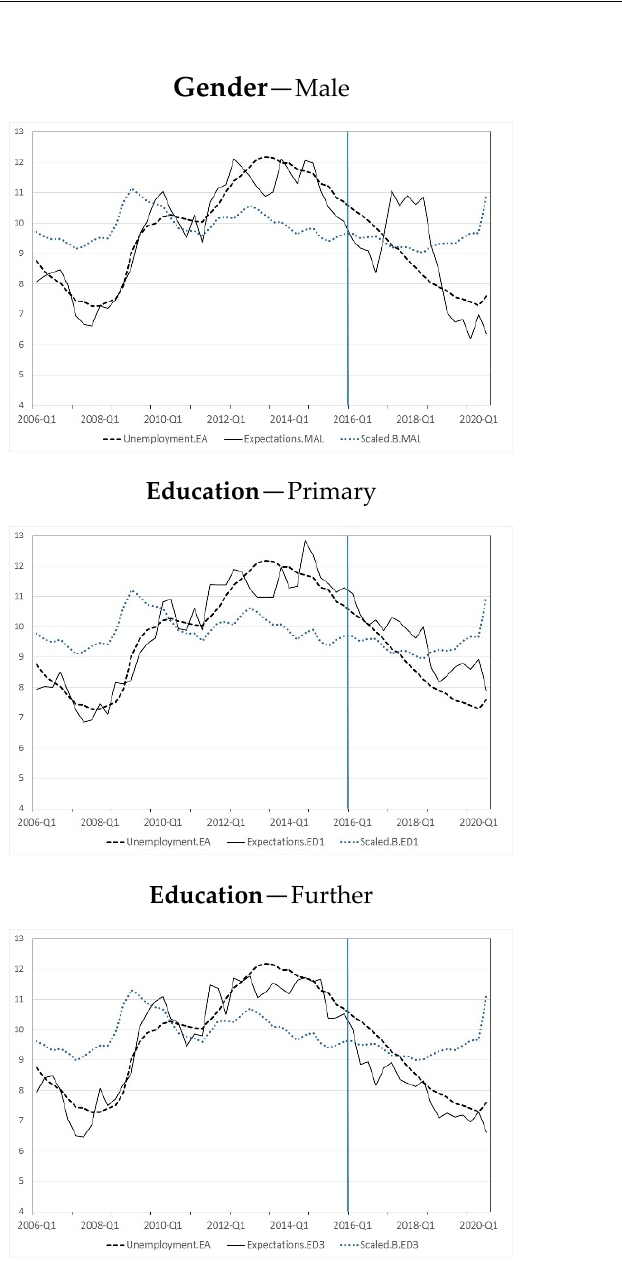
Figure A1. Evolution of unemployment expectations for each consumer group. Notes: The black line represents the evolution of the unemployment expectations for each sociodemographic group of consumers, the dashed black line the evolution of the unemployment rate, and the grey dotted line the evolution of the scaled balance of survey question X7 for each group. The vertical line in 2016.Q1 marks the beginning of the out-of-sample period.